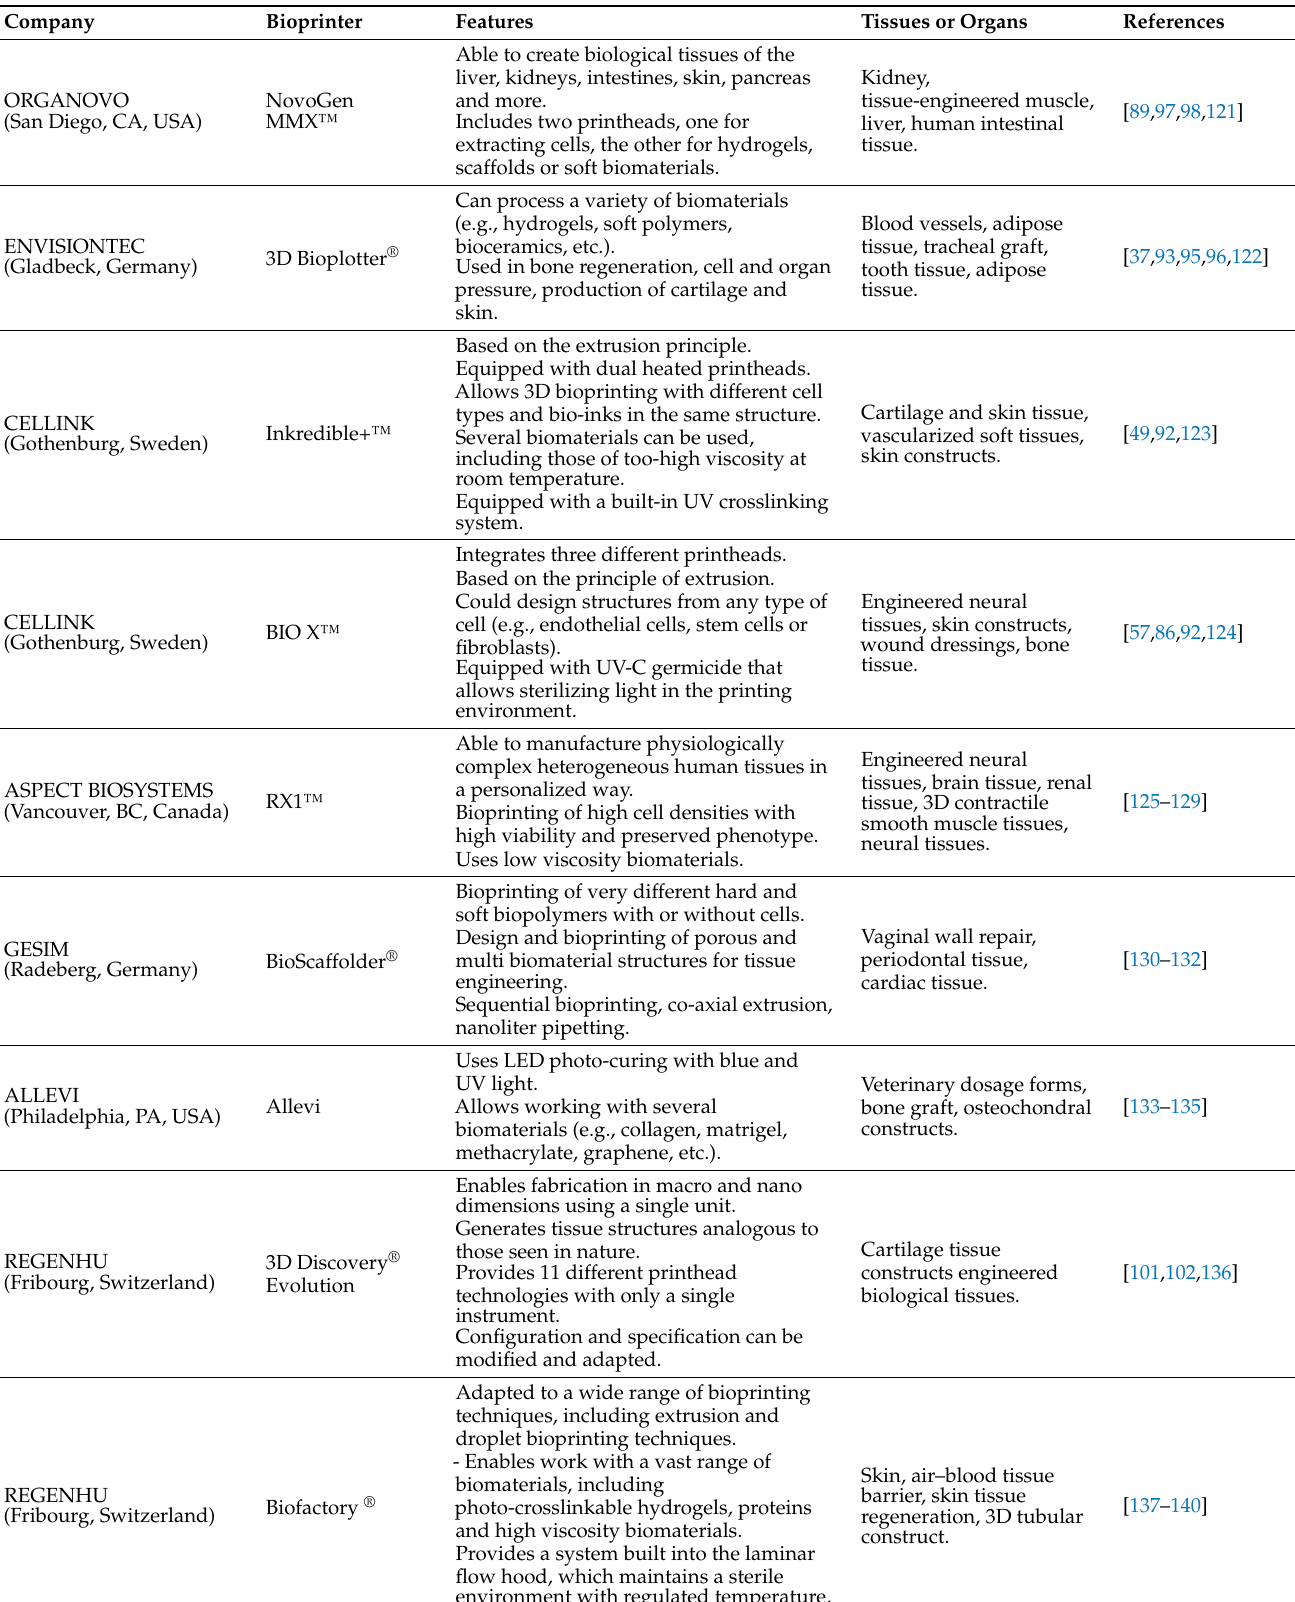
Table 1. Examples of 3D bioprinters using hydrogel-based bio-inks in tissue engineering and regener- ative